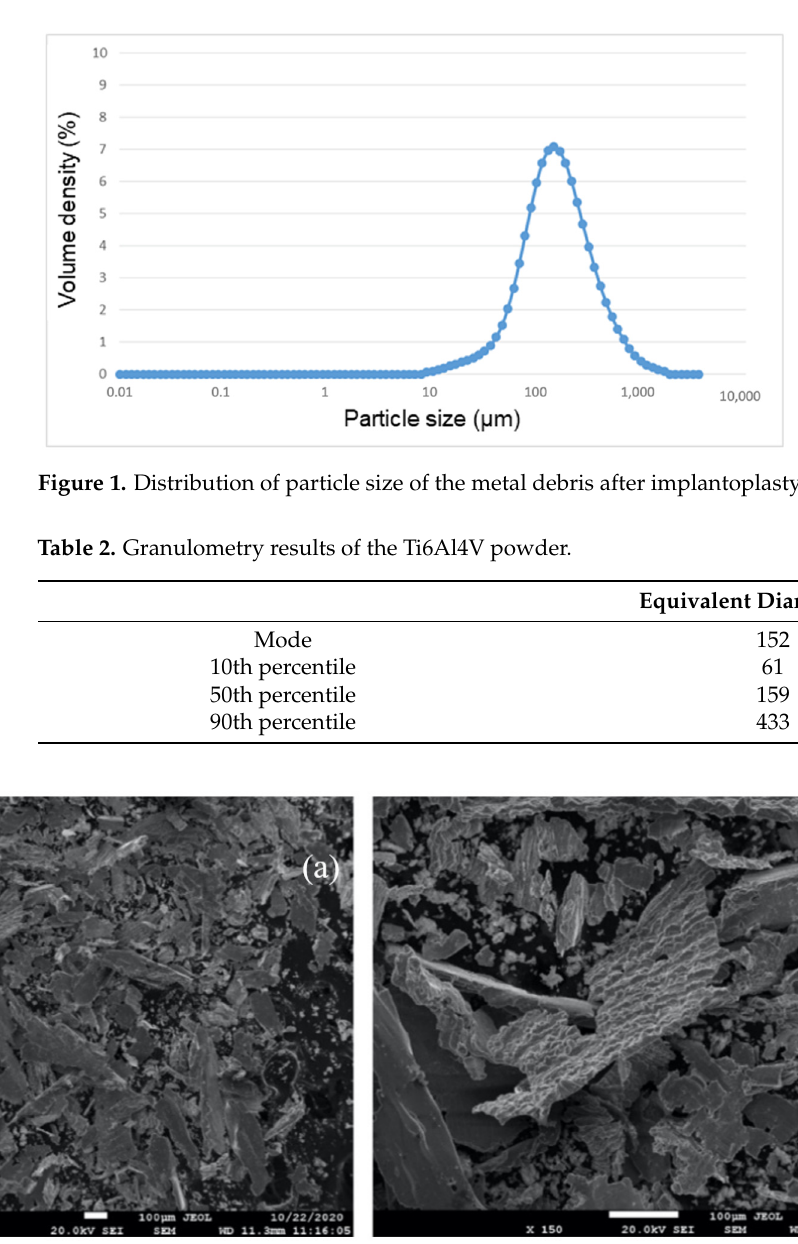
Figure 2. Scanning electron microscopy images under different magnifications; ( a ) ×50, ( b ) ×150.